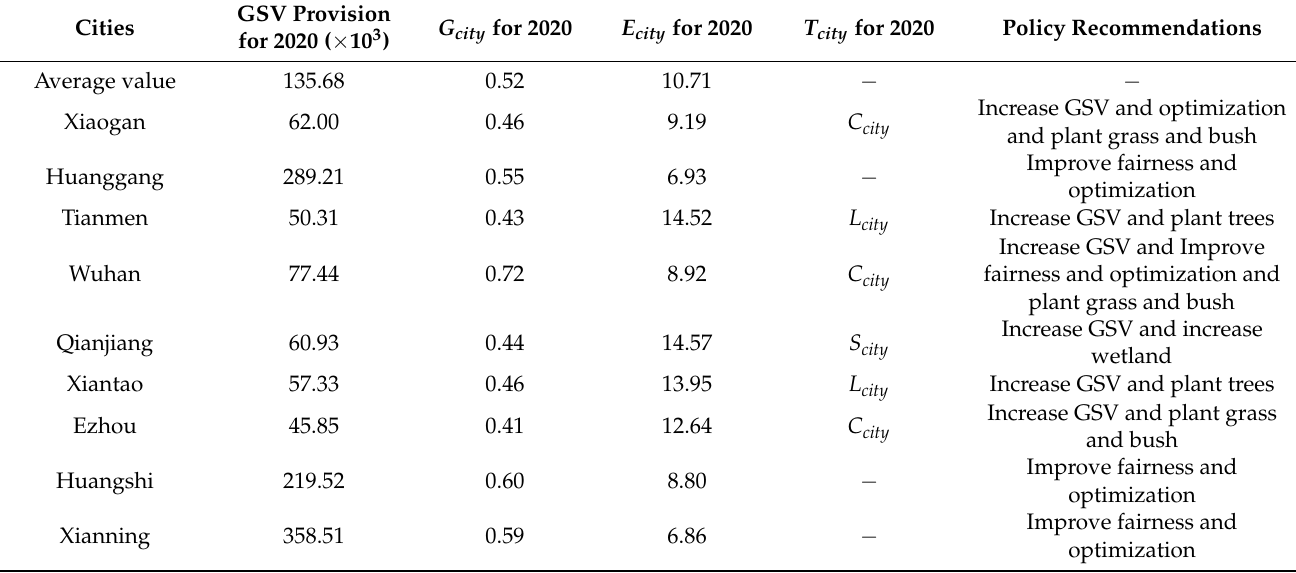
Table 2. Statistical indicators and future policy recommendations for different